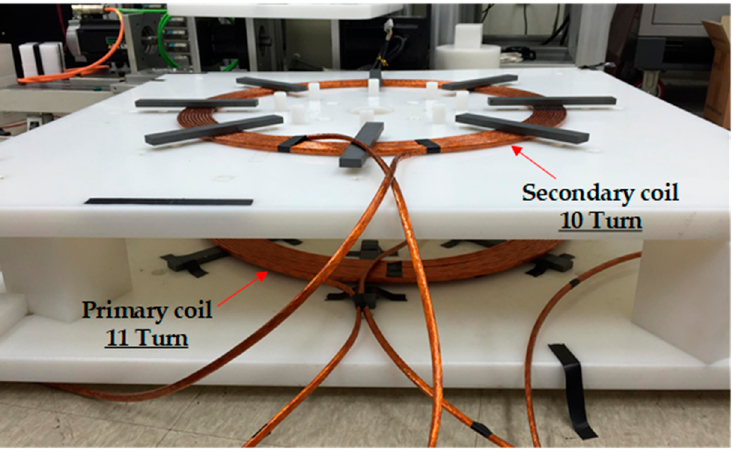
Figure 9. Coils built for power transmission.